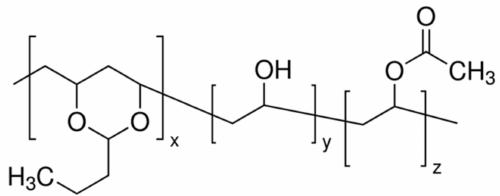
Figure 1. Chemical structure of poly(vinyl butyral-co-vinyl alcohol-co-vinyl acetate) (PVBVA) (from Sigma-Aldrich catalog, Reference